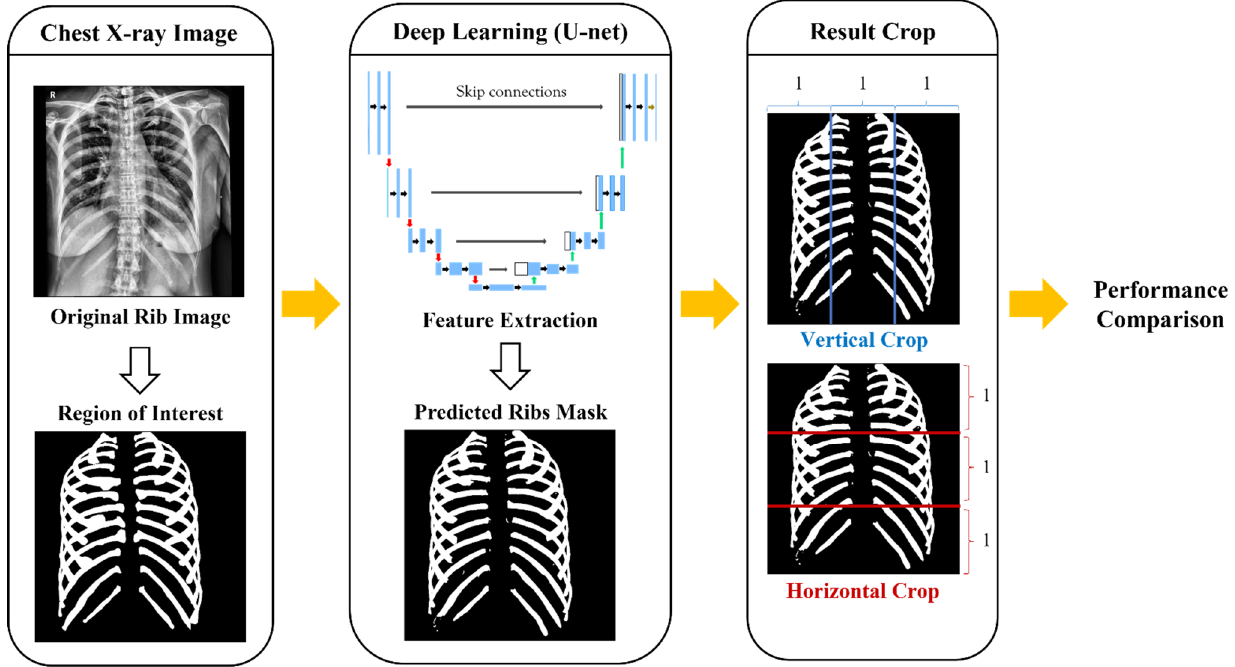
Figure 1. Flowchart that presents the total process of comparing region performance by dividing the predicted ribs’ mask.